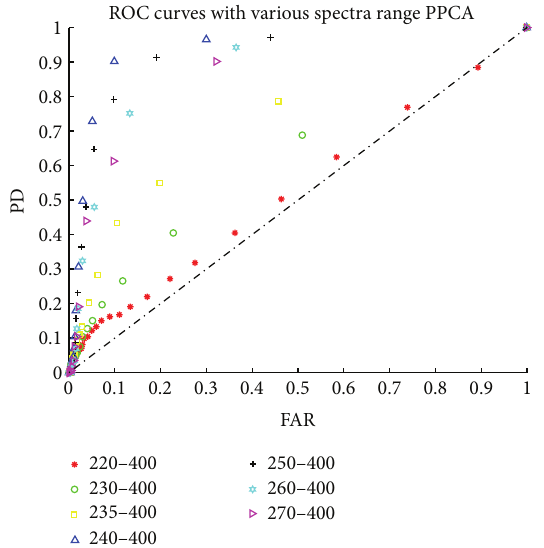
Figure 9: Receiver operation characteristic (ROC) curves for comparison. Figure 10: Receiver operation characteristic (ROC) curves with various spectra